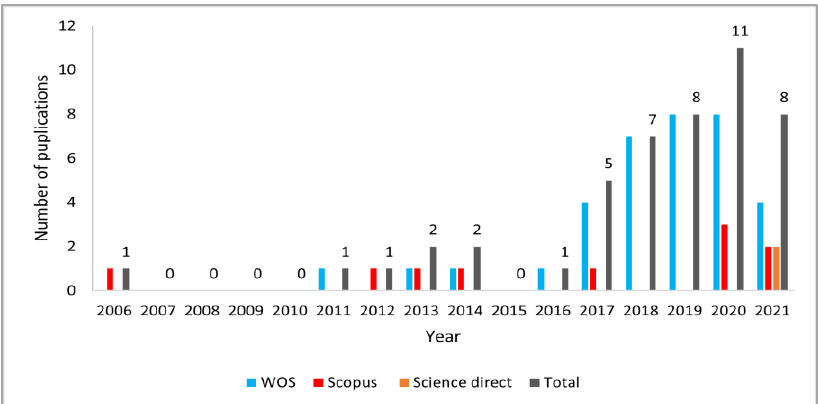
Figure 4. Yearly publication distribution of the refined publications.